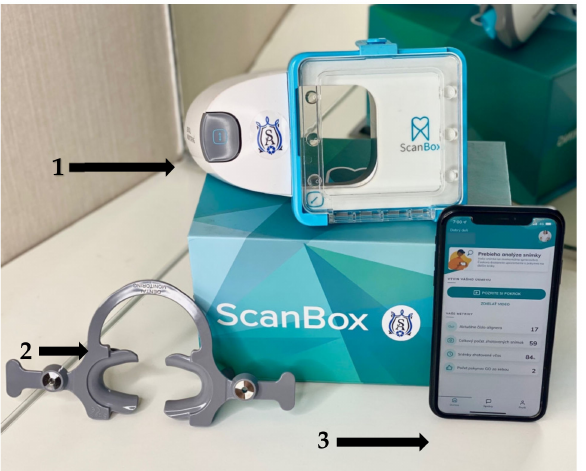
Figure 2. The Dental Monitoring ® (DM) (Dental Monitoring Co., Paris, France) set up—from the left is the retractor, the middle top is the dental monitoring scan box, and the right is the patient’s